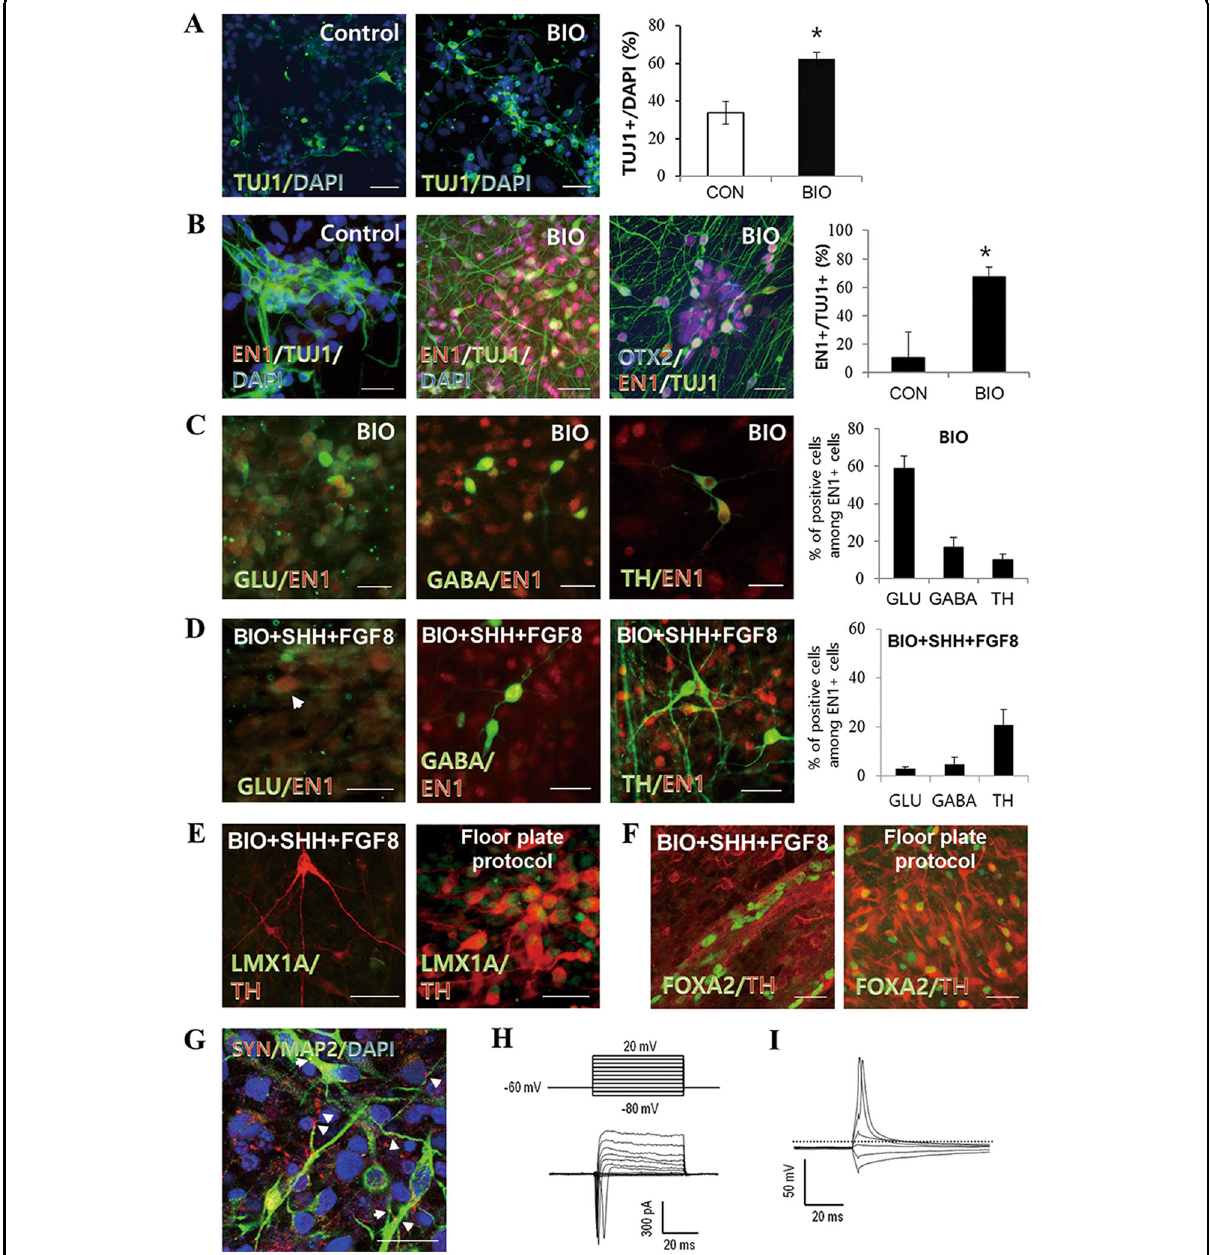
Fig. 4 Generation of functional midbrain neurons from the NPCs pre-exposed to BIO. a , b NPCs treated with BIO gave rise to TUJ1-positive and TUJ1/EN1 double-positive cells more than non-treated control NPCs. Note that the majority of EN1-positive neurons in BIO-treated group co- expressed OTX2 ( b ). c NPCs treated with BIO differentiated into various neuronal subtypes, primarily Glu-positive cells followed by GABA-positive and TH-positive cells. d The proportion of neuronal subtype cells differentiated by treatment with SHH and FGF8 following BIO. TH-positive cells were the most abundant, followed by GABA-positive and Glu-positive cells. e , f TH-positive cells generated by sequential treatment of BIO and SHH + FGF8 rarely co-expressed LMX1A or FOXA2 whereas TH-positive cells differentiated by fl oor plate-based protocol 20 were highly positive for both markers. g – i Neurons derived from NPCs treated with BIO were functional, as exempli fi ed by the immunoreactivity of synaptophysin on dendrites (indicated by white arrows; g ) and voltage-dependent membrane currents (bottom traces; h ), depolarizing voltage steps (top traces; h ) as well as evoked action potential by current injection ( i ). Bars in the graphs are presented as mean ± standard deviation. Statistical signi fi cance was determined by Student ’ s t test; * p < 0.05. Scale bars: 20 μ